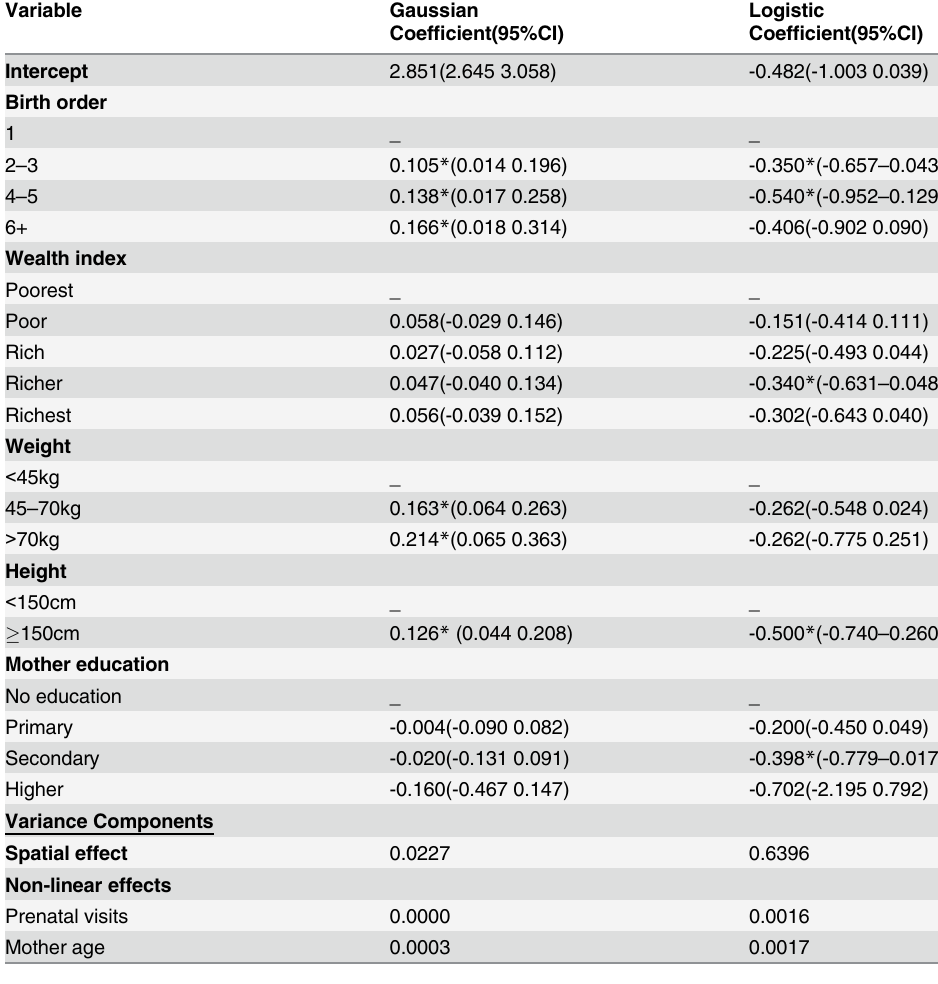
Table 3. Summary of Gaussian and binary logistic